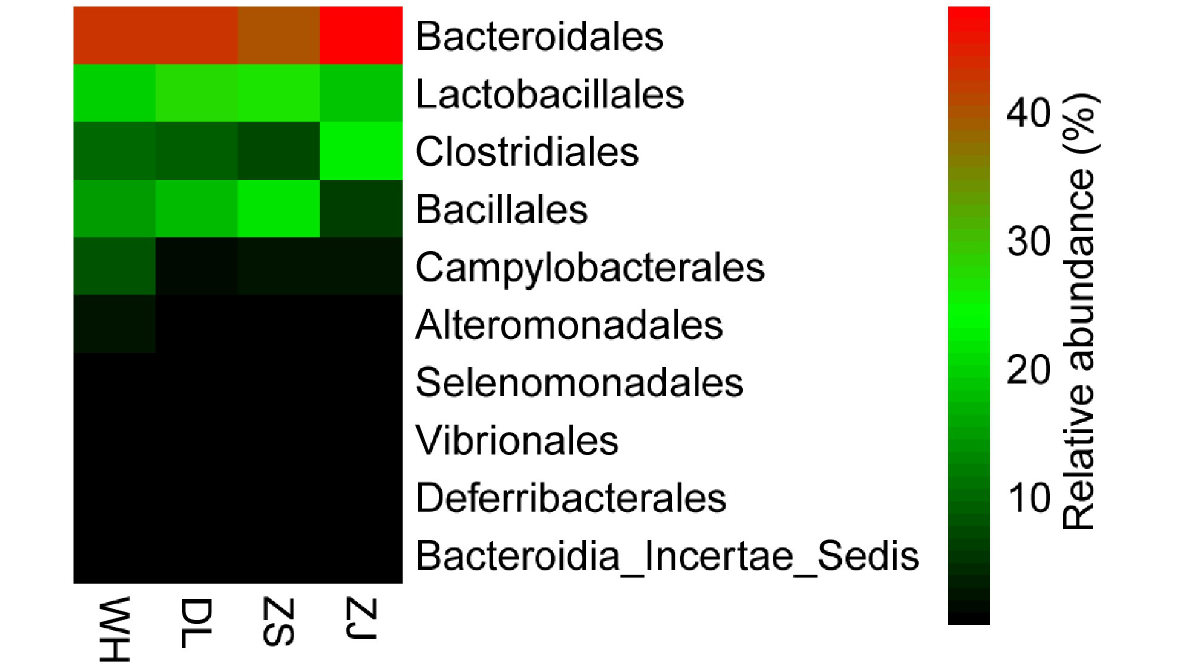
Fig 6. Abundance of the overlapping orders of the RPMs from four coastal locations in